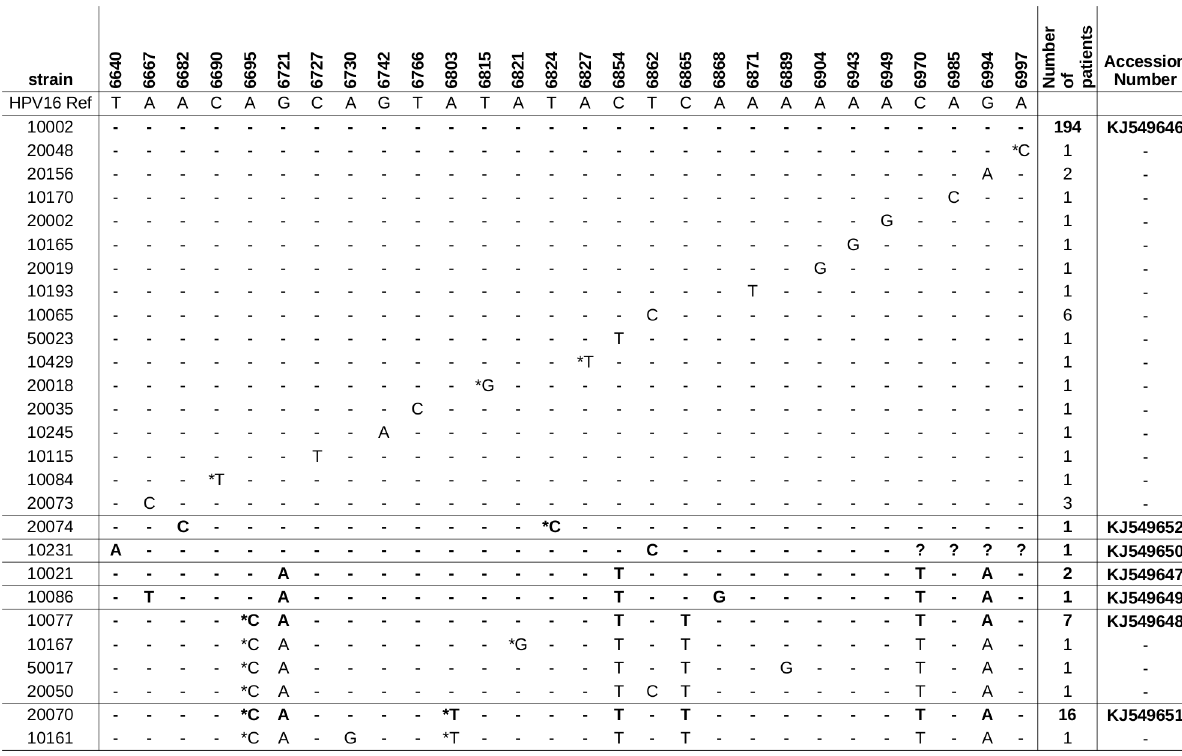
Table S3 Frequency of SNP 350G of European (E)